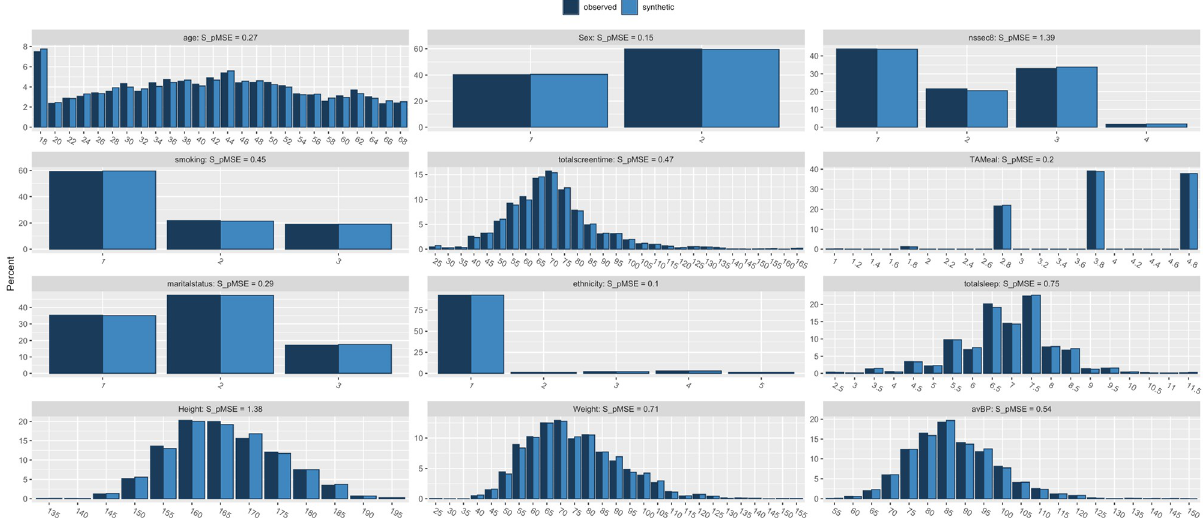
Fig 2. Histogram comparison for each variable comparing the aggregate demographic characteristics of the real training dataset (n = 2408) against synthetic dataset B (n = 4816).